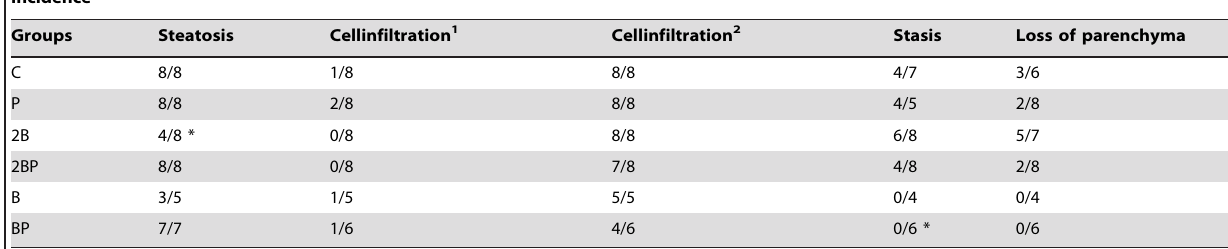
Table 3. Evaluation of liver injury